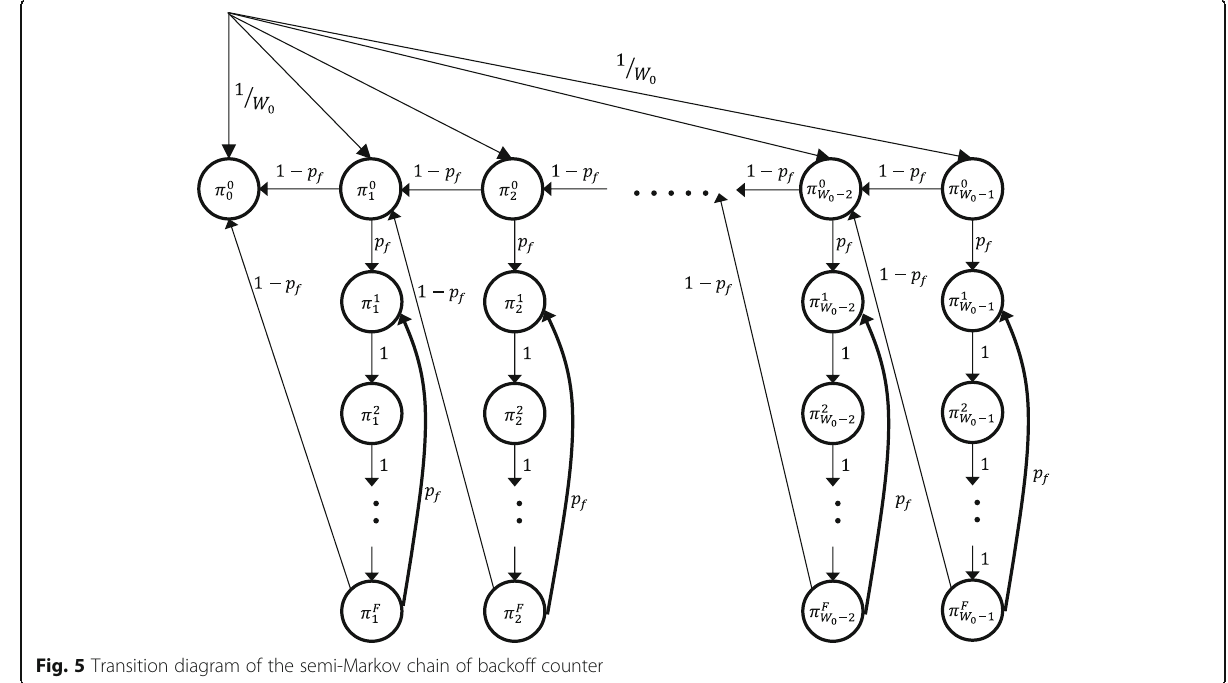
Fig. 5 Transition diagram of the semi-Markov chain of backoff